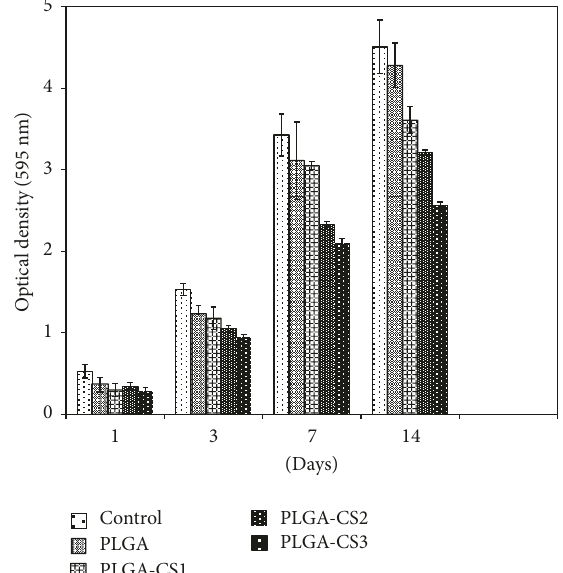
Figure 6: Percentage of cell viability on the series of the diluted extracted solution of PLGA MPs and PLGA-CS MPs. Figure 7: Cellular proliferation on the control, PLGA MPs, and PLGA-CS MPs 1, 3, 7, and 14 days